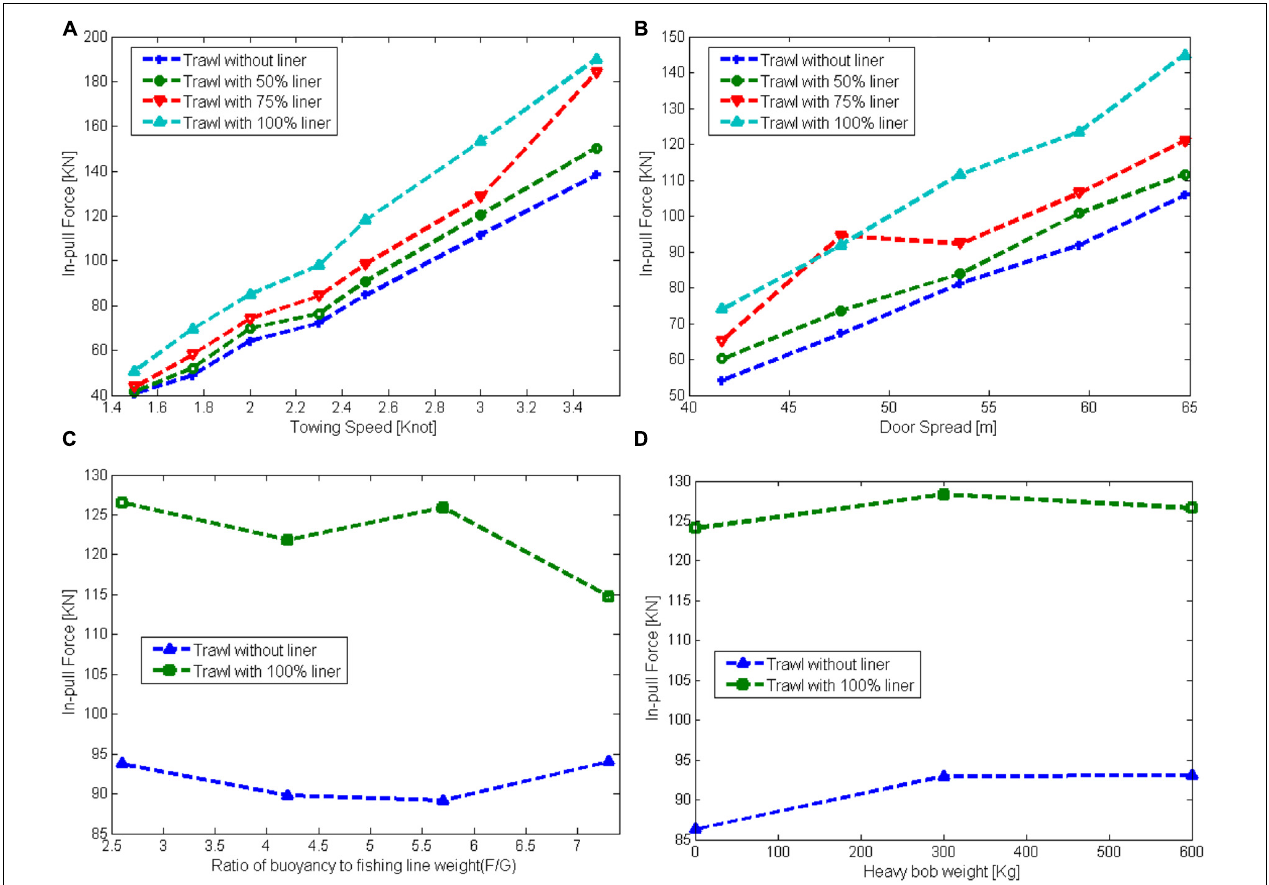
FIGURE 5 | The in-pull force of the different trawls about the (A) towing speed, (B) door spread, (C) ratio of buoyancy to fishing line weight ( F / G ), and (D) heavy bob weight: current data estimated with 95% confidence intervals from the statistical analysis.